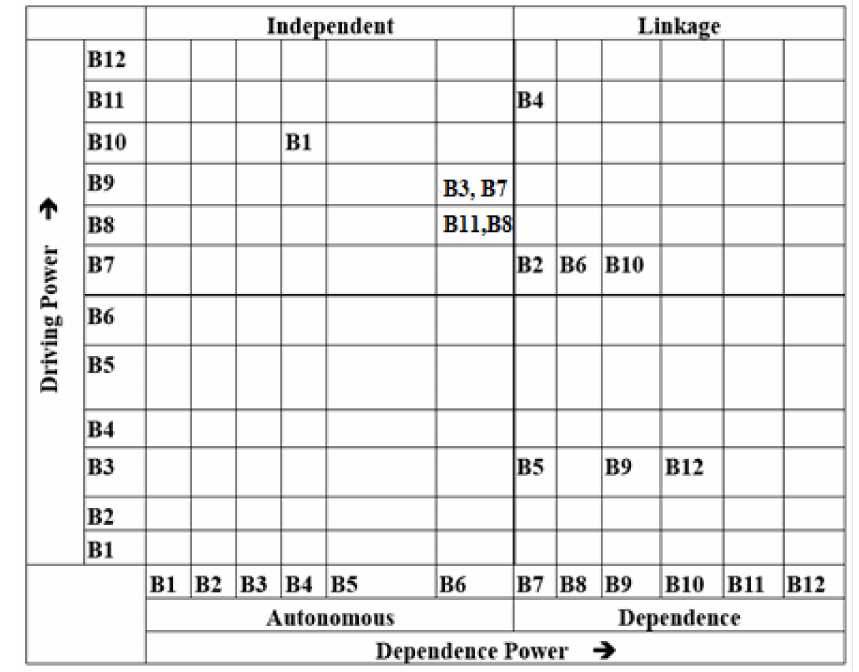
Figure 6. Results of the MICMAC